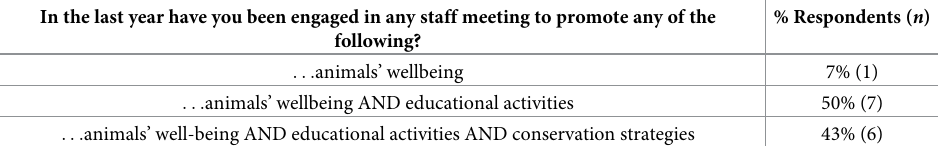
Table 6. Distribution of answers to question n.